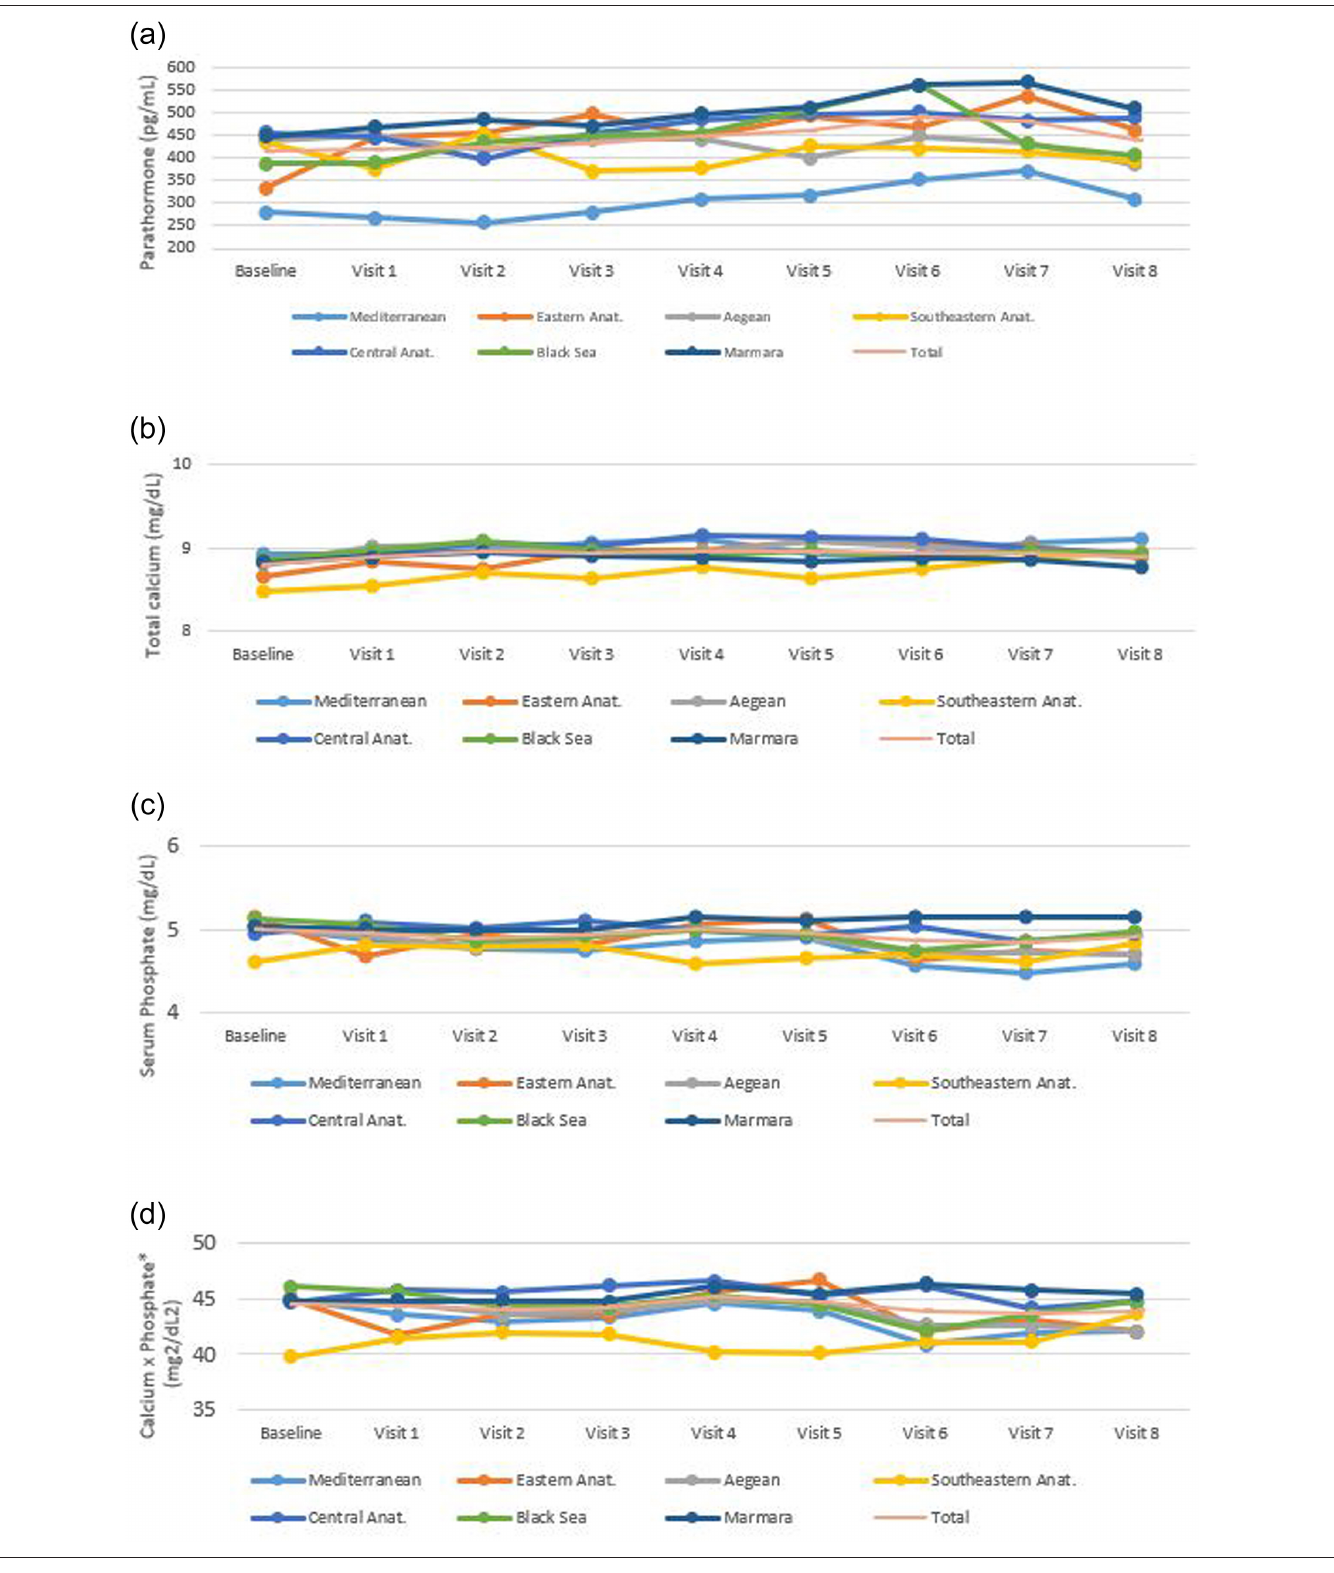
Figure 3. Regional differences in the mean serum levels of (A) parathormone, (B) total calcium, (C) phosphate, and (D) calcium × phosphate product. *Calcium level was corrected in patients with hypoalbuminemia ( < 3.5